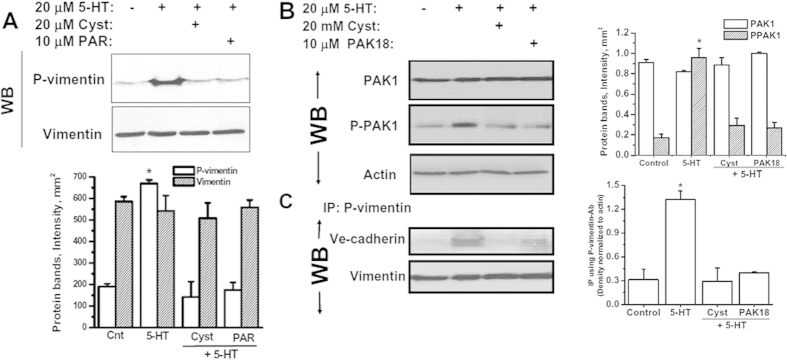
TGase and 5-HT in P-vimentin formation.(A) In exploring our hypothesis in the involvement of TGase in phosphorylation of vimentin, endothelial cells (2 × 105 cells/assay) were treated with TGase inhibitor Cys and our experimental condition was PAR-treated endothelial cells. Endothelial cells were pretreated with 20 μM 5-HT or Cys or PAR or 5-HT + Cyst/PAR. The whole cell lysate were resolved on SDS-PAGE followed by WB analysis using a polyclonal P-vimentin or vimentin-Ab. Densitometric scanning of the immunoblots in was performed, and asterisks indicate samples that significantly differ between the groups. Results from three independent experiments are shown (mean ± S.D. (error bars)). While 5-HT pretreatment mediated the phosphorylation of vimentin (lane 2), the presence of Cys or PAR ceased the upregulatory role of 5-HT in P-vimentin formation (lanes 3 and 4). (B) PAK and P-vimentin formation and ve-cadherin association with P-vimentin. Endothelial cells (2 × 105 cells/assay) were treated with 20 μM 5-HT or Cys or 10 μM PAR1 inhibitor, PAR1-18. Pretreated or control endothelial cells were lysed and a portion of it was saved for WB analysis with PAK1- or P-PAK1- or actin-Ab. The rest of the cell lysates were prepared for the co-IP assay with P-vimentin Ab (polyclonal) coated sepharose A beads. The IP were eluted and subjected to WB analysis with ve-cadherin Ab (monoclonal). The level of P-vimentin on was found elevated in 20 μM 5-HT pretreated cells; but this elevation was stored in PAR treatment. Nonspecific adsorption of Sepharose beads was not determined in the absence of vimentin-Ab. Figures show representative images from 3 separate experiments. Actin was used as a loading control. Quantification of the results from the panel was performed by densitometric scanning and presented after normalized with actin. The association between cadherin and P-vimentin was 4.25-fold higher in 5-HT pretreated, 1.86-fold higher in 5-HT and Cyst or PAK1-18 treated endothelial cells than the control group indicating that P-vimentin can be formed in different pathways although 5-HT signaling is the major one. This result is significantly different from the level of 5-HT + Csyt or 5-HT + PAR treated samples association (two-sided t test, p < 0.05). Results from three independent experiments are shown (mean ± SD).